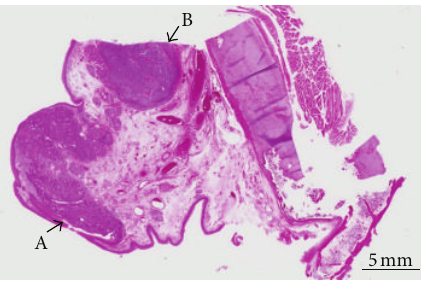
Figure 2: Loupe image of the larynx. Two individual cancer components were noted: A (A) squamous cell carcinoma (SCC) component and a (B) small cell carcinoma (SmCC) component. Collision was not seen among these 2 components.